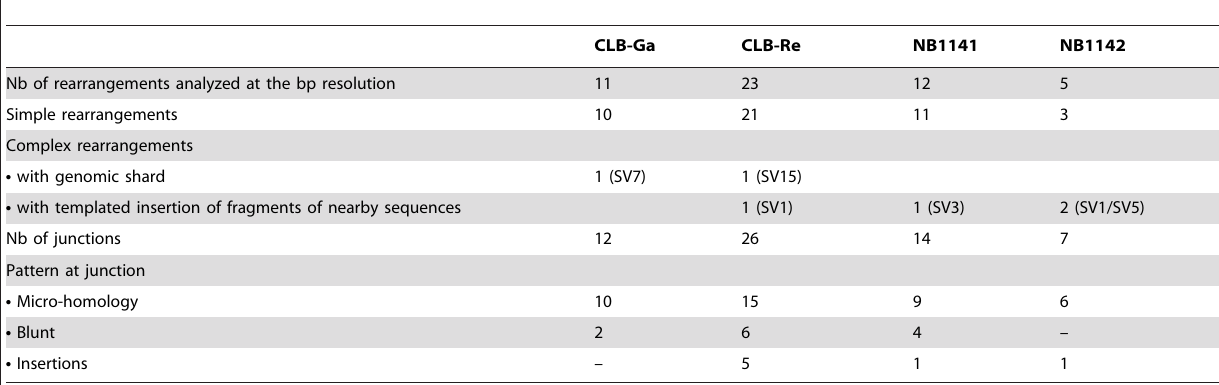
Table 3. Characteristics of junctions defined at the base pair